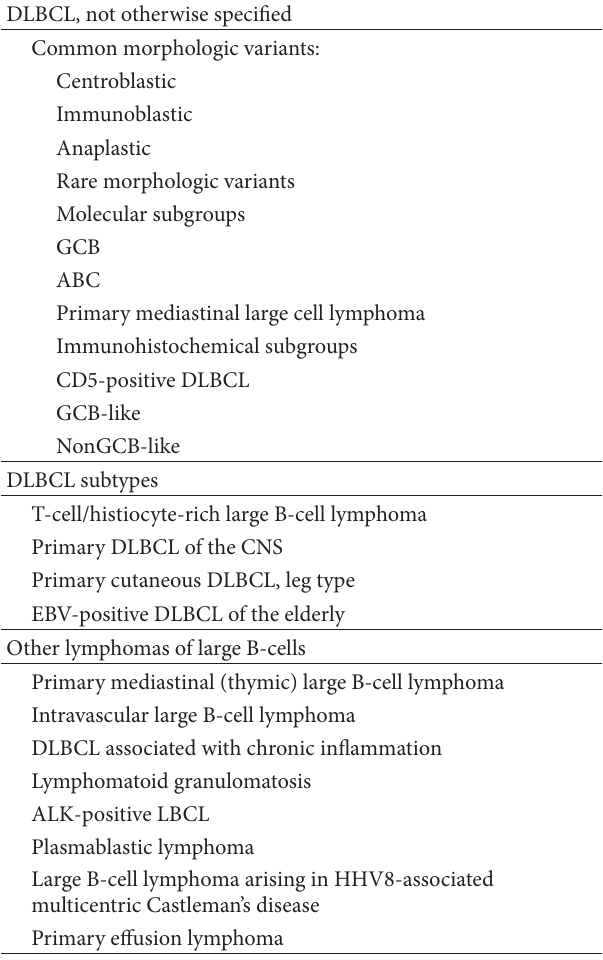
Table 1: DLBCL variants, subgroups, and subtypes (from Mey et al.